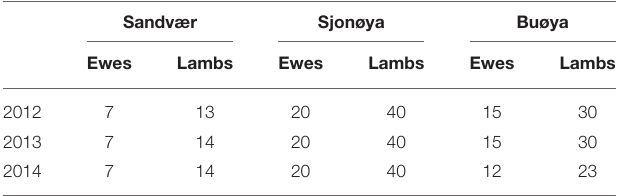
TABLE 2 | Number of Norwegian White ewes and lambs at Sandvær, Sjonøya, and Buøya in 2012–2014. Sandvær